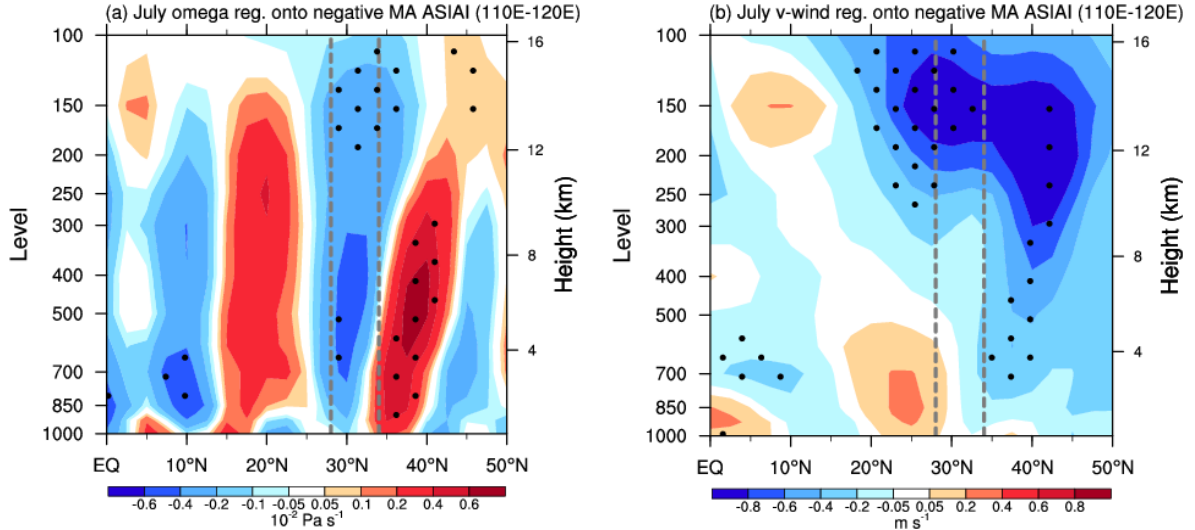
Figure 7. Vertical latitude section (110° E–120° E) of the July–mean ( a ) vertical velocity (shading; unit: 10 − 2 Pa s − 1 ) and ( b ) meridional wind (shading; unit: m s − 1 ) anomalies regressed onto the normalized negative MA–mean ASIAI for the period 1980–2016. Regression coefficients that are significant at the 90% confidence level are stippled. The thick blue horizontal bars superimposed onto the abscissa of panels ( a , b ) indicate the latitudes bounding the YHRB Meiyu region.